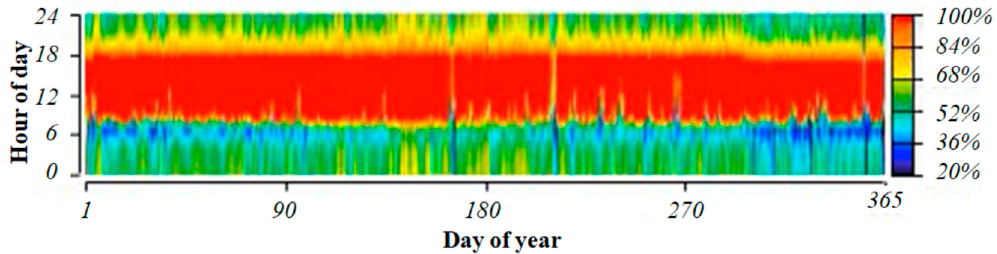
Figure 17. The monthly SOC of BSS is provided in Figure 18.